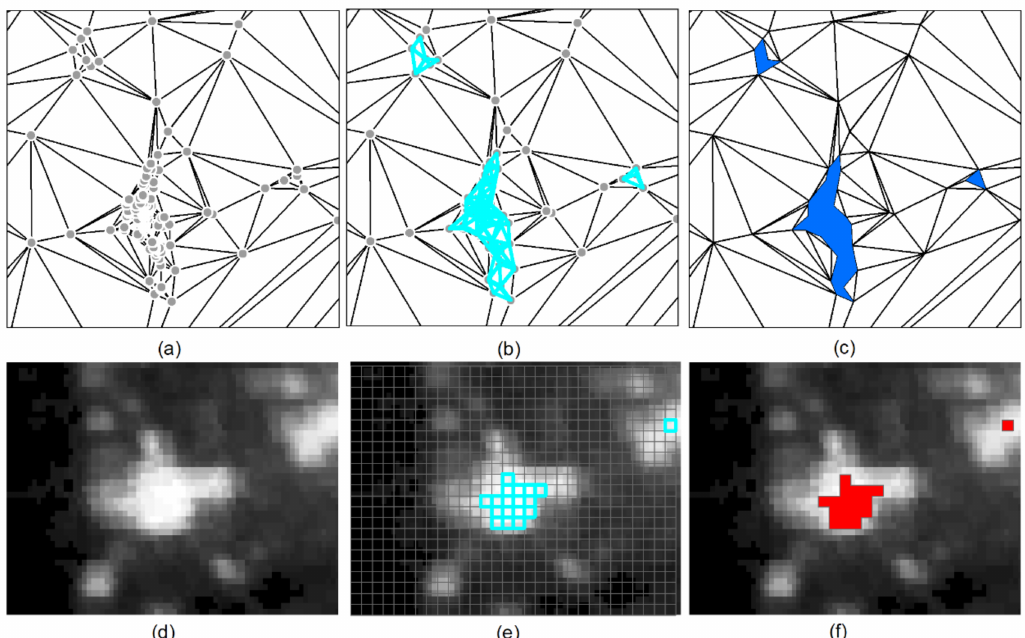
Figure 2. (Color online) The derivation of urban hotspots using the spatial clustering approach based on respectively street nodes ( a – c ) and NTL image pixels ( d – f